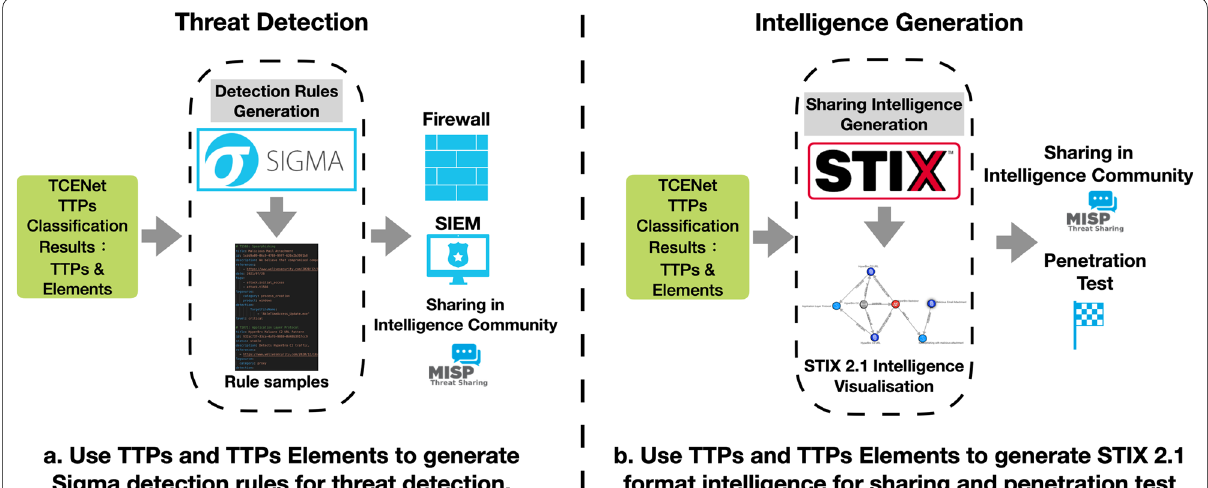
Fig. 5 We use TTP descriptions and TTP elements obtained from the TIM framework for threat detection and intelligence